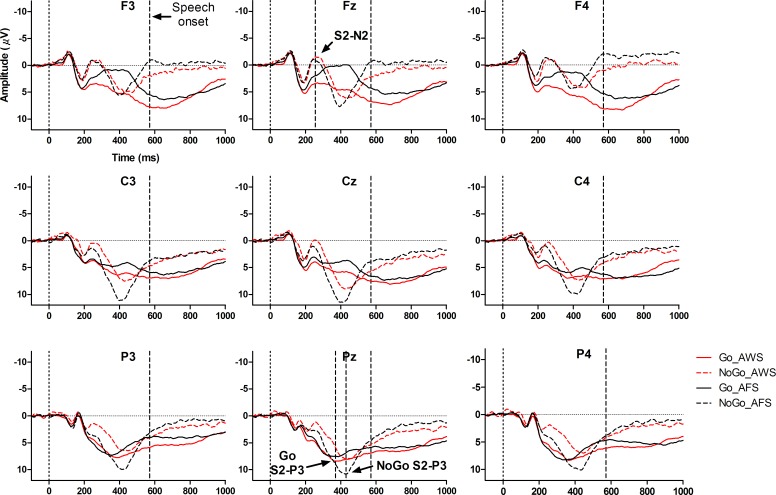
The S2-evoked ERPs.The mean amplitudes of ERPs at different electrodes are presented for AWS (red solid line) and AFS (black solid line) under the Go condition and for AWS (red dashed line) and AFS (black dashed line) under the NoGo condition. The mean RTs (speech onset time) are indicated in vertical dashed lines. An example of S2-N2 is shown at Fz, and an example of S2-P3 is shown at Pz.